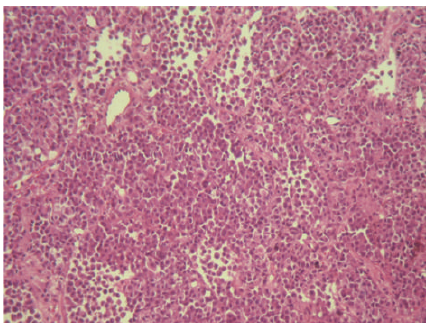
Figure 1: Di ff use proliferation of rounded neoplastic cells showing incohesion (HE × 40).